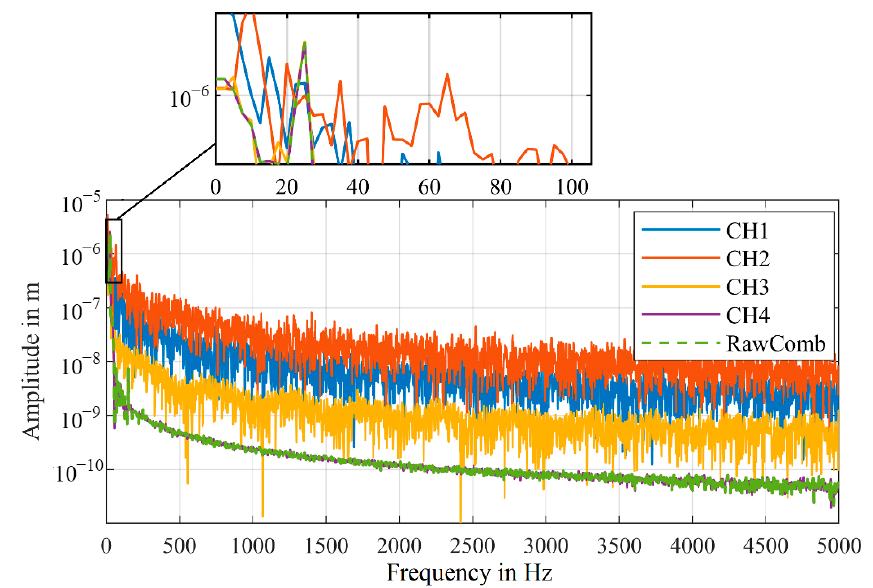
Figure 18. Frequency spectra of the four channels CH1–CH4 and the combined signal; poor alignment of the measurement heads; (RBW = 2.5 Hz).